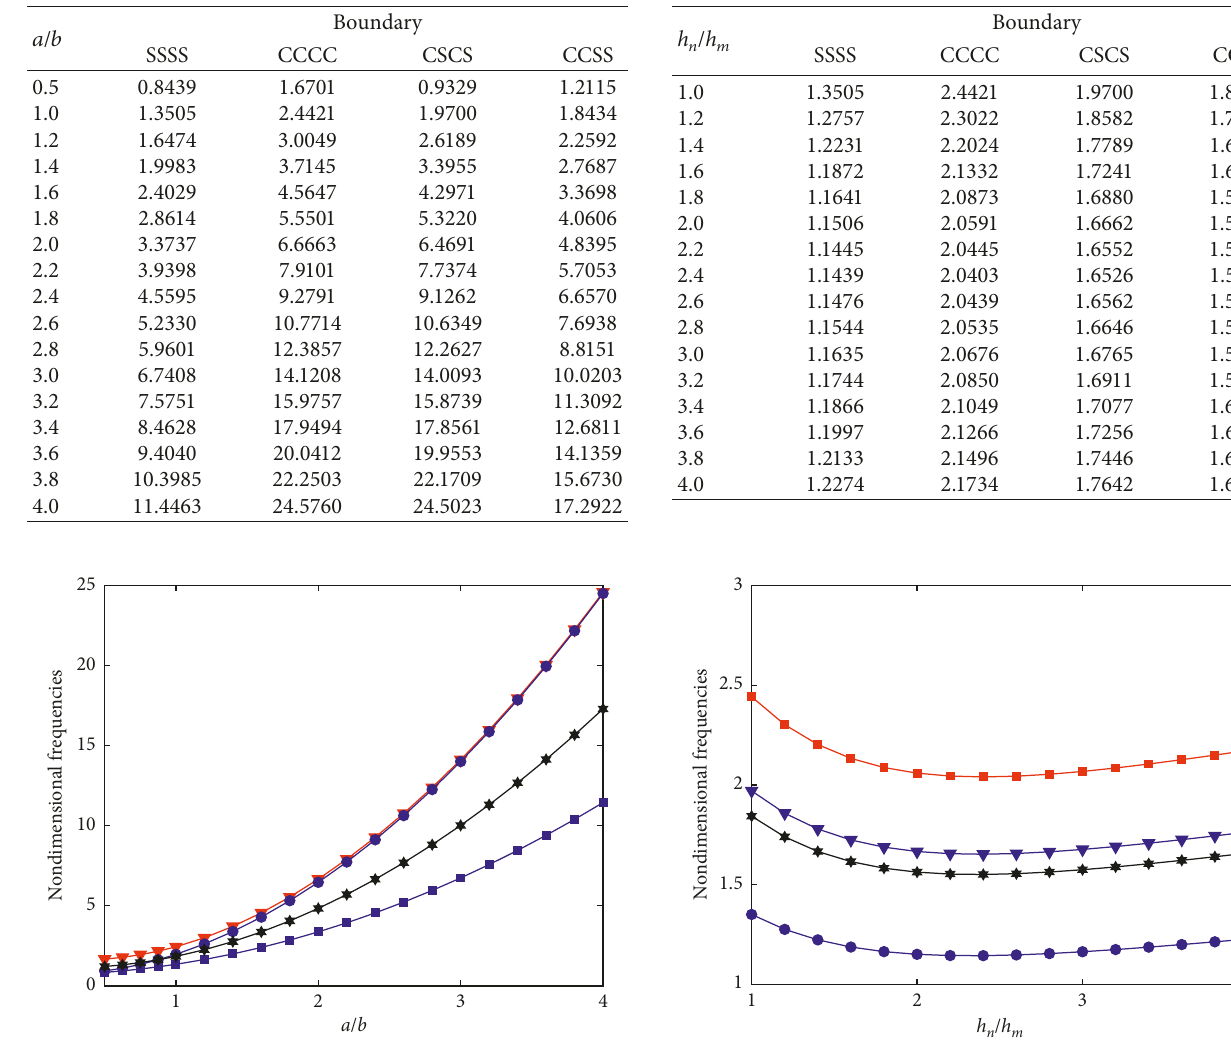
Table 9: Influence of ratio a / b on nondimensional fundamental frequency of the plate with h n / h m � 1 and k